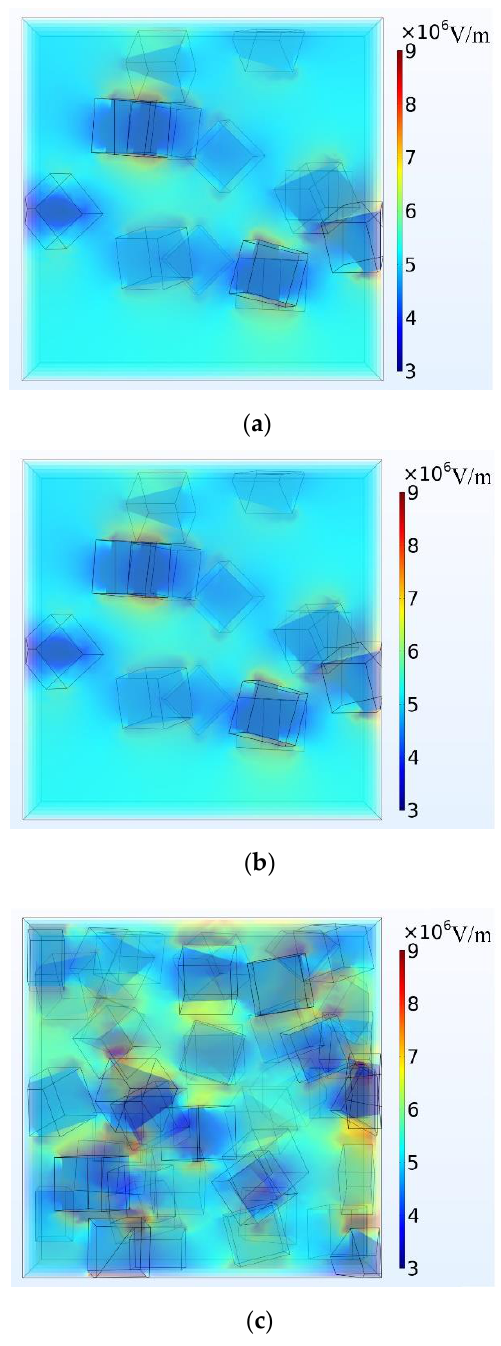
Figure 7. Cloud diagram of electric field distribution inside the composite material; ( a ) 10 wt% composite model; ( b ) 20 wt% composite model; ( c ) 30 wt% composite model.